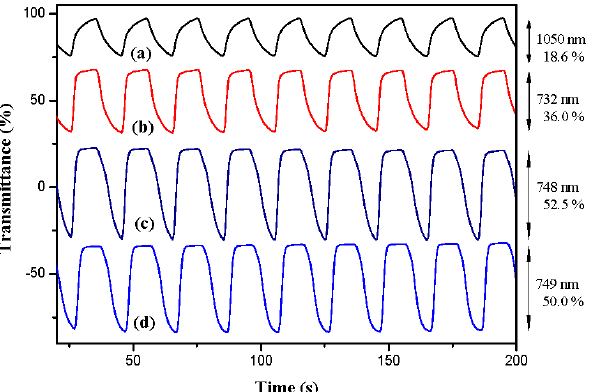
Figure 7. Optical contrast of: ( a ) PBCz; ( b ) P(BCz- co -EDOT); ( c ) P(BCz- co -ProDOT); and ( d ) P(BCz- co -EDTT) electrodes in a PC/ACN (1:1, by volume) solution containing 0.2 M LiClO 4 between 0.0 V and 1.2 V with a residence time of 10 s.